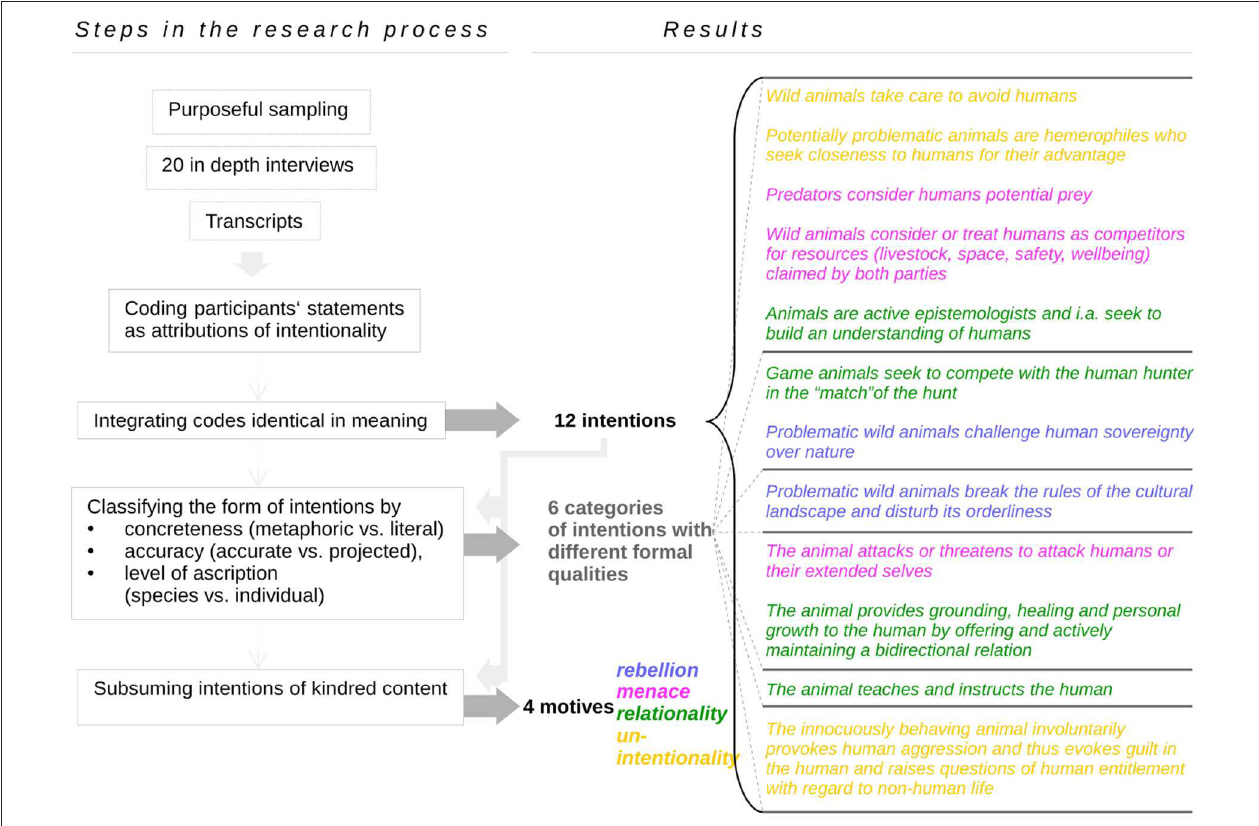
FIGURE 1 | Graphical abstract of the individual steps in the research process and the results they yield.